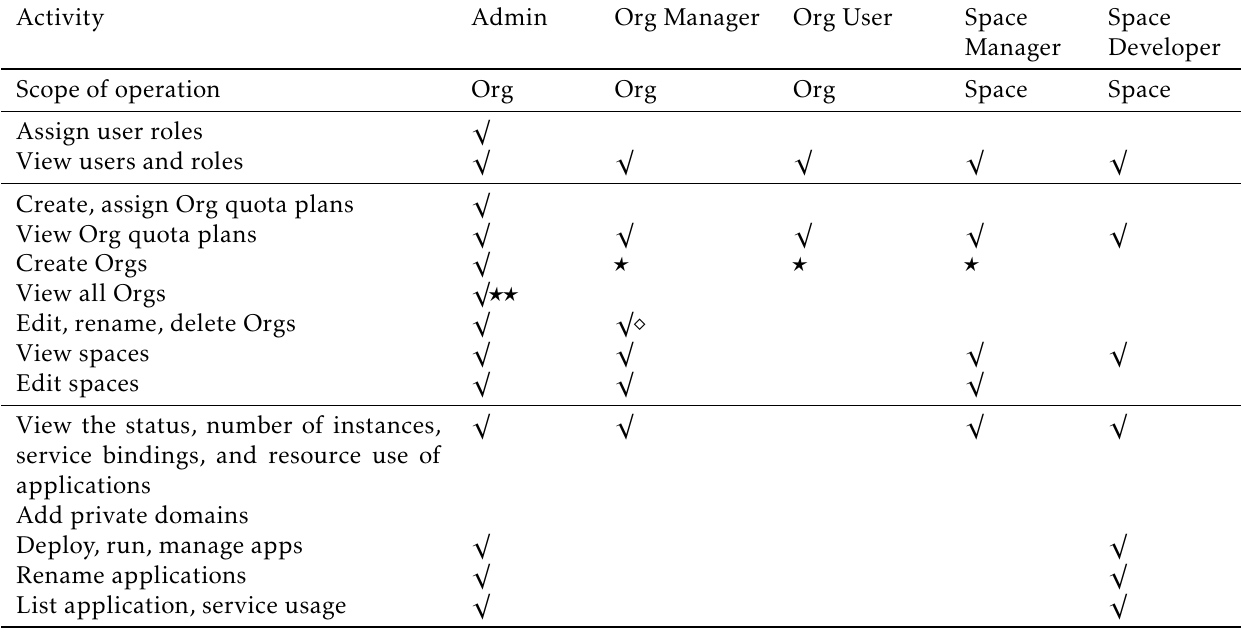
√ " indicates that access is